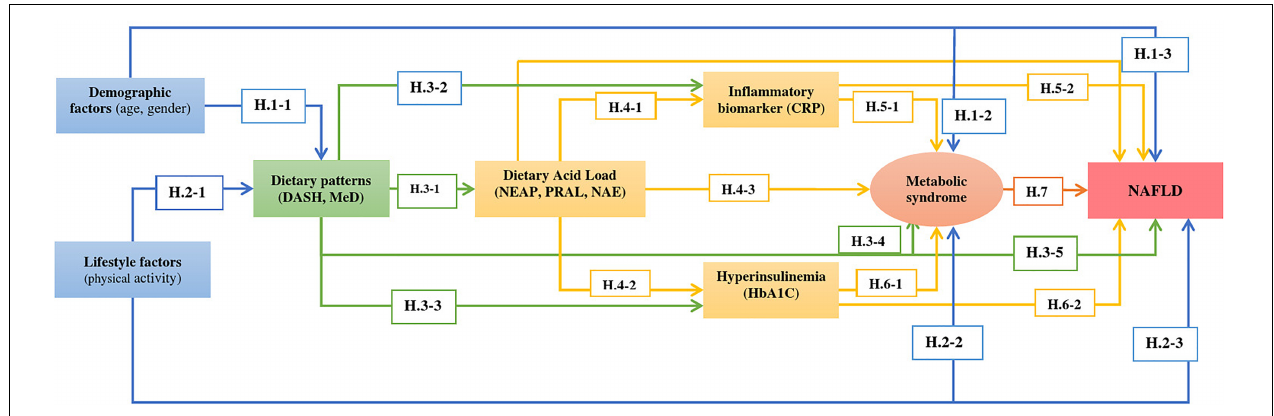
FIGURE 1 | Proposed model of the relationship between dietary patterns (DASH and MeD) and NAFLD considering the effect of other variables on determinants and outcome.